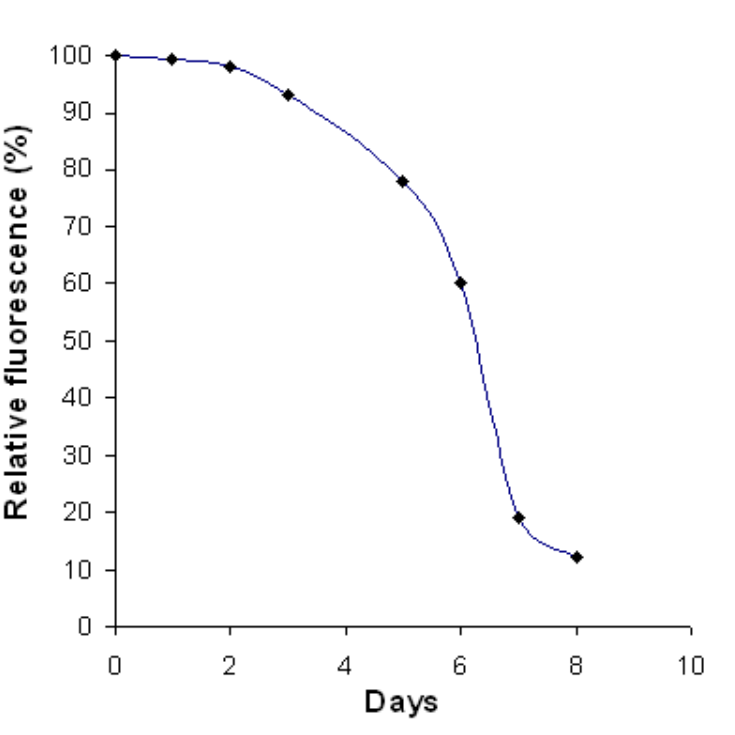
Figure 3. Effect of storage time on the stability of a 30 mM MBB solution in aceonitrile stored at room temperature up to 8 days and used to derivatize a 20 µM GSH solution. The relative fluorescence for the MBB solution immediately after preparation was set at 100.